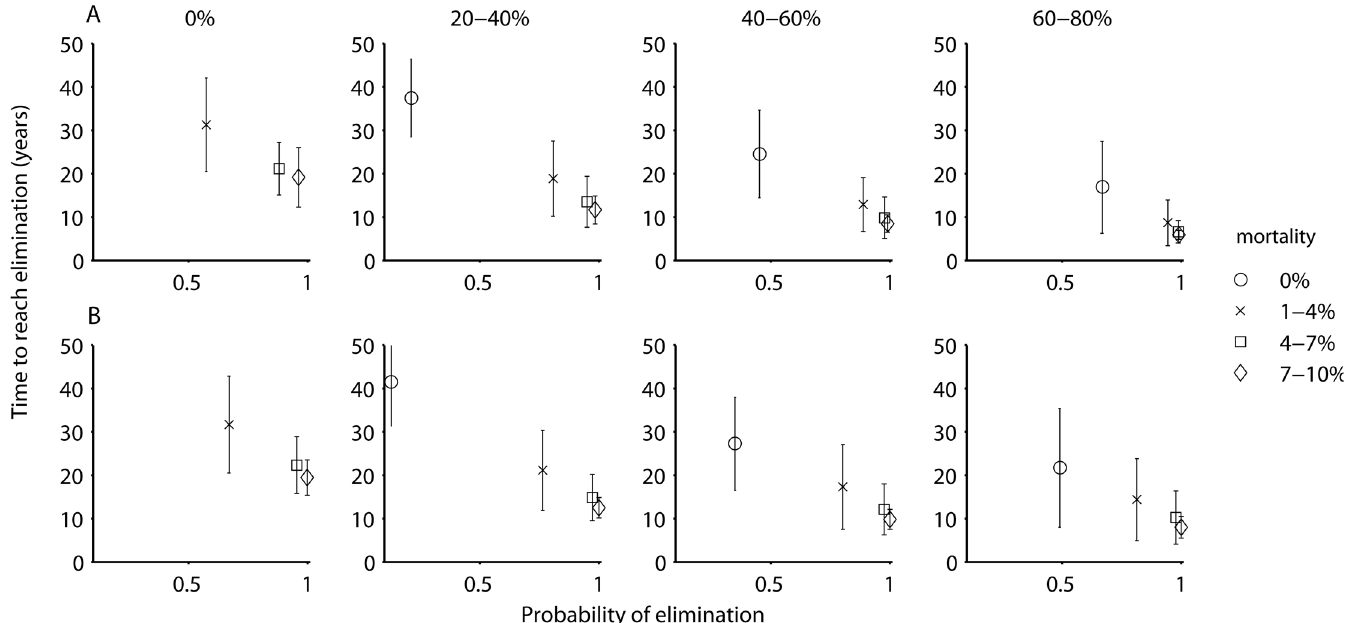
Fig 5. The proportion of simulations where HAT was eliminated (prevalence < 1 x 10 − 6 ) and the mean time to elimination with standard deviation, depending on the percentage of the human population screened per year (expressed as absent (0%), low (20 – 40%), moderate (40 – 60%), or high (60 – 80%) coverage and indicated by the plot titles), with varying levels of vector control (expressed as additional vector mortality, indicated by the symbols in the legend), for a high transmission setting without an animal reservoir (A) and with an animal reservoir (B).